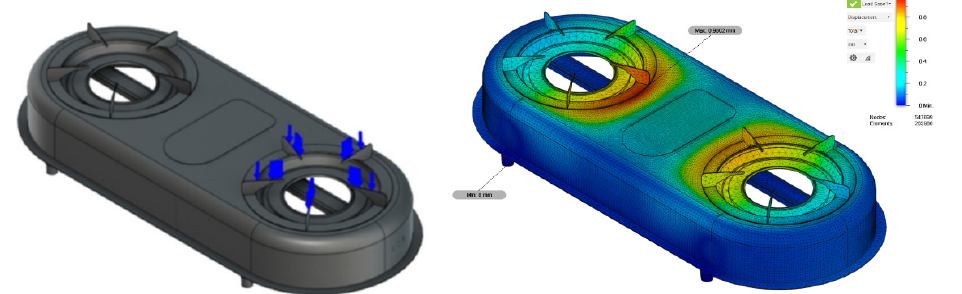
Figure 11. Loads and maximum displacement of the redesigned